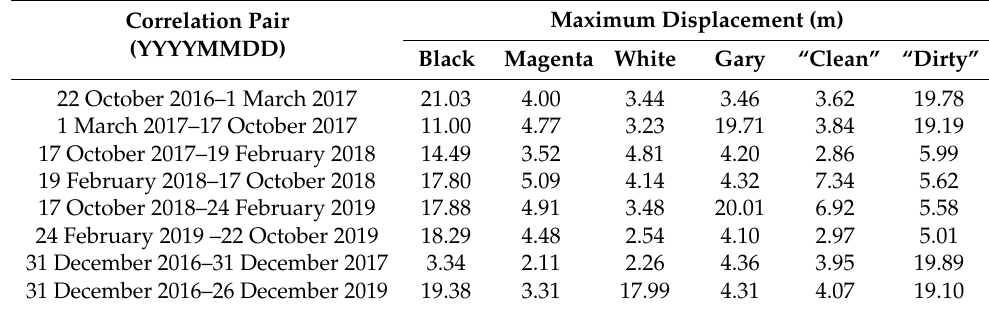
Table 5. Maximum Displacement of different rock salt in each Sentinel-2A/B image pair.